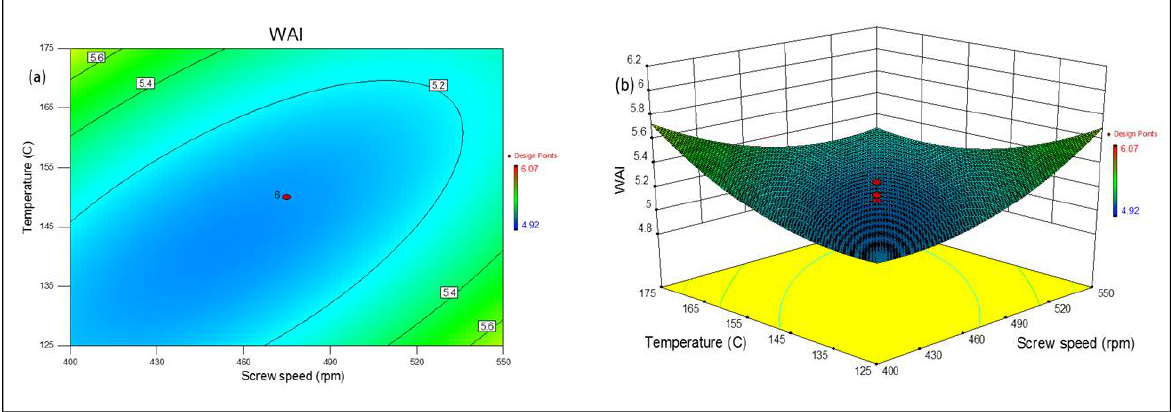
Figure 4: Contour (a) and its response surface plot (b) depicting the behavior of Water Absorption Index (WAI) at different barrel temperature and screw speed while the other processing variables are at center